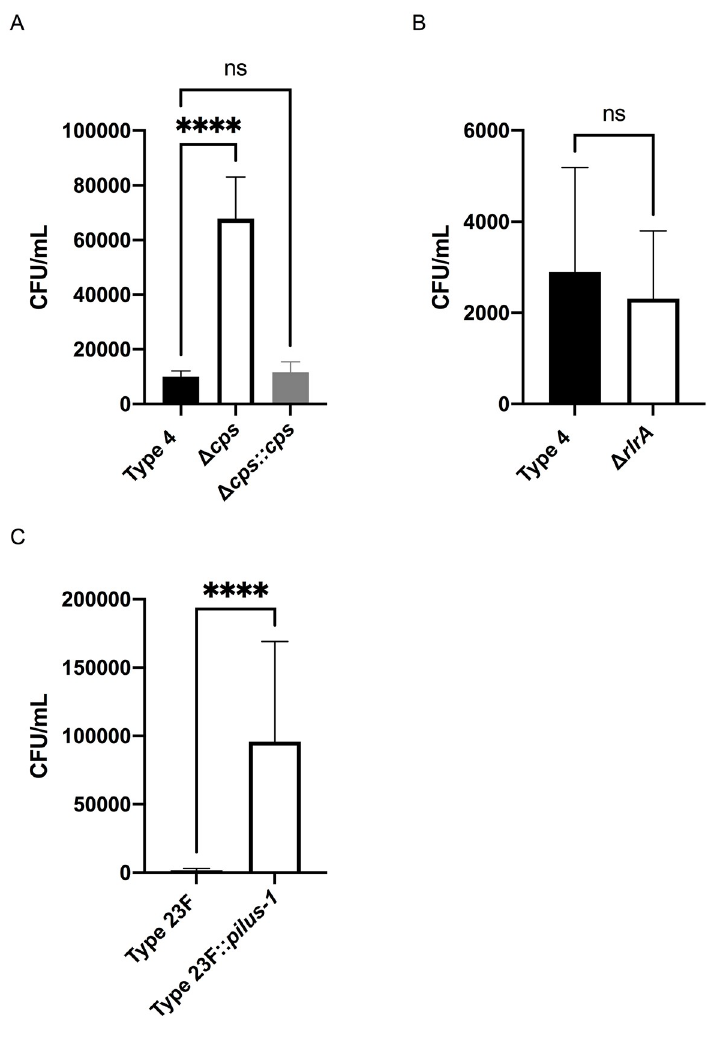
Fig 2. Screening of pneumococcal surface factors interacting with mucus. Adherence of WT Spn and isogenic mutants to pooled mNL or hNF was assessed in a solid phase assay. Bacteria (2x 10 4 CFU/100 μ l DMEM) were incubated with 100 μ L of undiluted, immobilized, pooled mNL in presence of 0.1% BSA for 2hr at 30˚C. After 19 washes, adherent bacteria were determined by resuspending with 0.001% Triton X-100 following plating on TS agar plates supplemented with 200 μ g/ml streptomycin. (A) Adherence of Type 4 (TIGR4), Δ cps and Δ cps :: cps to mNF. (B) Adherence of Type 4 (TIGR4) and Δ rlrA to mNF. (C) Adherence of Type 23F and Type 23F:: pilus-1 to hNF. Experiments were performed in duplicates and mean values of three independent experiments are shown with error bars corresponding to S.D. ���� ,p < 0.0001 by one-way ANOVA followed by Dunnett’s multiple comparison test for multiple comparison (A) or Mann-Whitney test